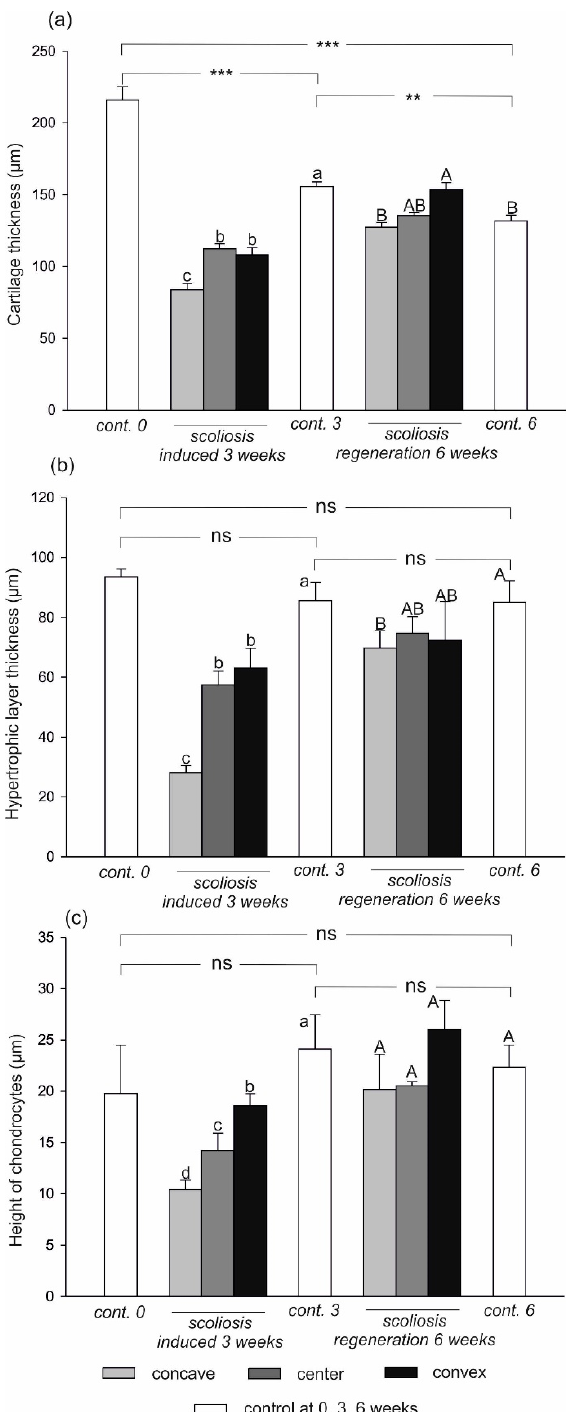
Figure 2. Cartilage thickness ( a ), hypertrophic layer thickness ( b ), and height of chondrocytes ( c ) in the rat treatments. Data are means ± SD (n = 4). Means followed by various letters differ significantly ( p < 0.05, Tukey’s test) **, and *** indicate significant differences from the different controls at the, 0.01, and 0.001 levels of Student’s t -test at 0, 3, and 6 weeks.